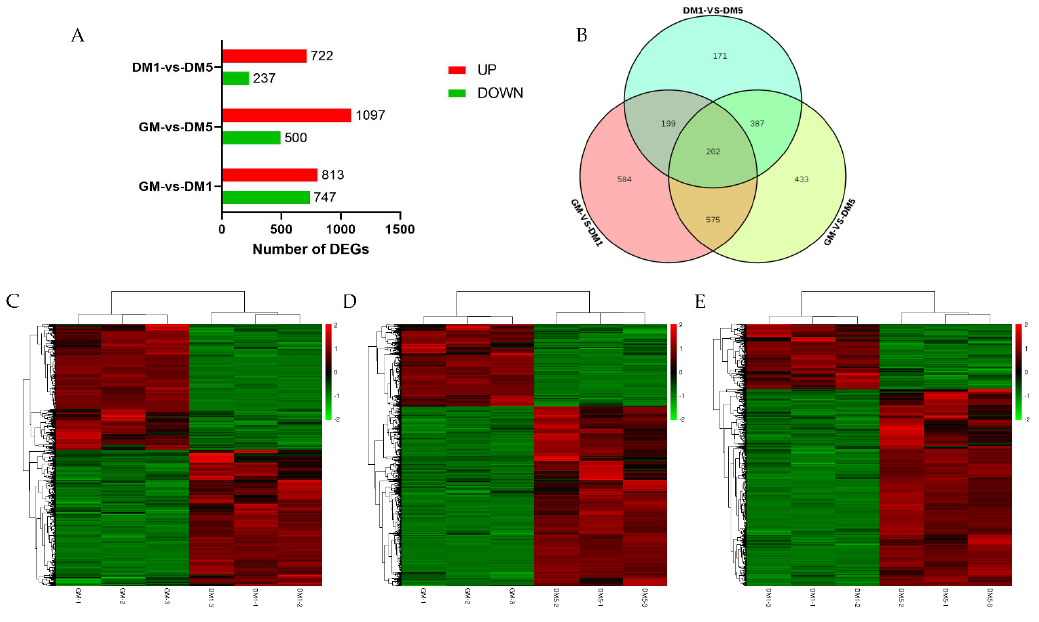
Figure 3. Differentially expressed genes (DEGs) analysis. ( A ) Numbers of upregulated and down- regulated genes in goat MuSCs in three phases. ( B ) A venn diagram depicting the DEGs in various phases. ( C – E ) Hierarchical clustering analysis of DEGs through pairwise comparisons. Red denotes a high level of expression, whereas green denotes a low level of expression.